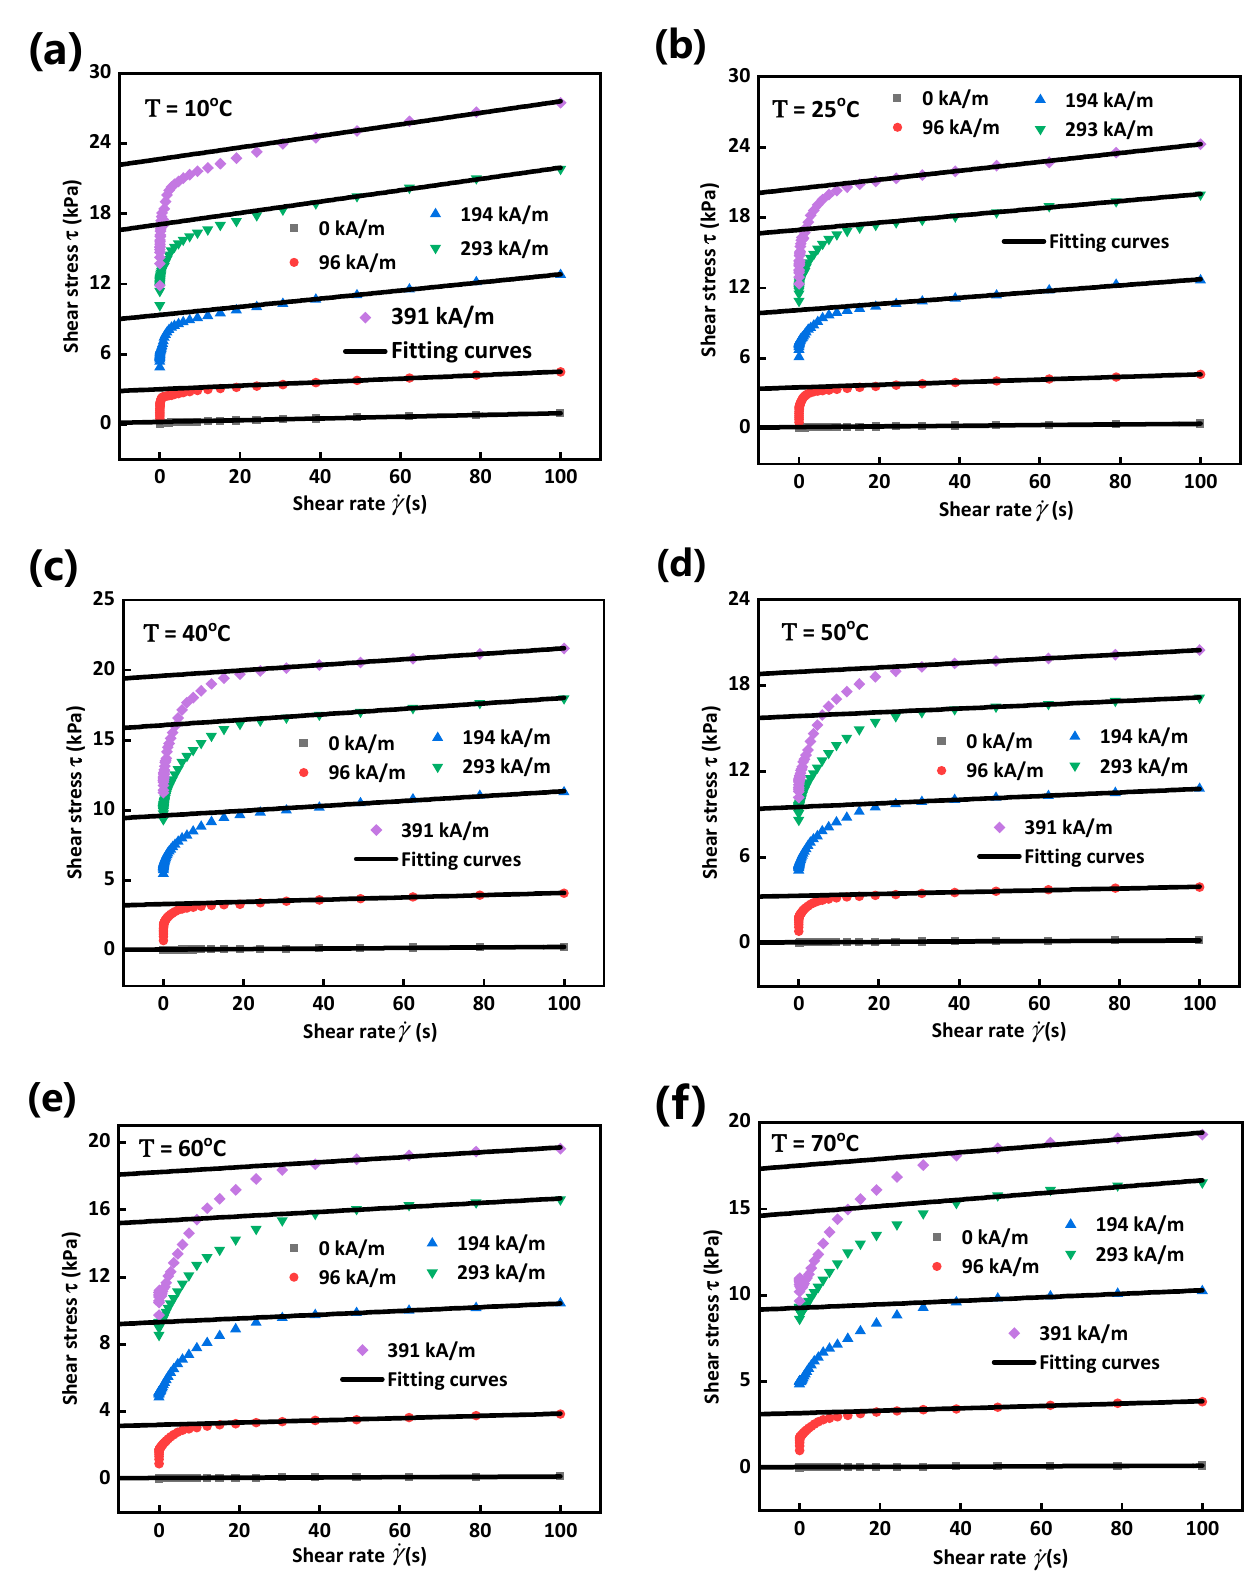
Figure 5. Fitting curves of maximum yield stress of MRG under different magnetic field strengths and temperatures. 10 °C ( a ), 25 °C ( b ), 40 °C ( c ), 50 °C ( d ), 60 °C ( e ) and 70 °C ( f ). Where 𝜏 , 𝜏 , 𝜂 and 𝛾(cid:4662) denote shear stress, yield stress, plastic viscosity and shear (cid:3052) rate, respectively. The fitting curves and magnitudes of maximum yield stress under six different temperatures and five magnetic field strengths are presented in Figures 5 and 6.